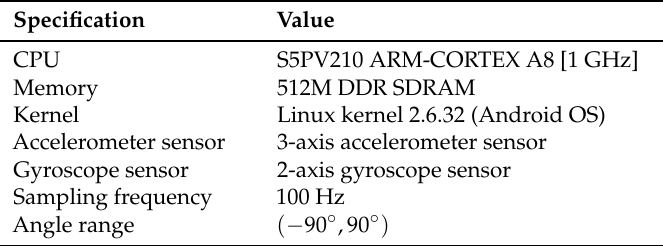
Table 1. Specifications of the experimental mobile device.